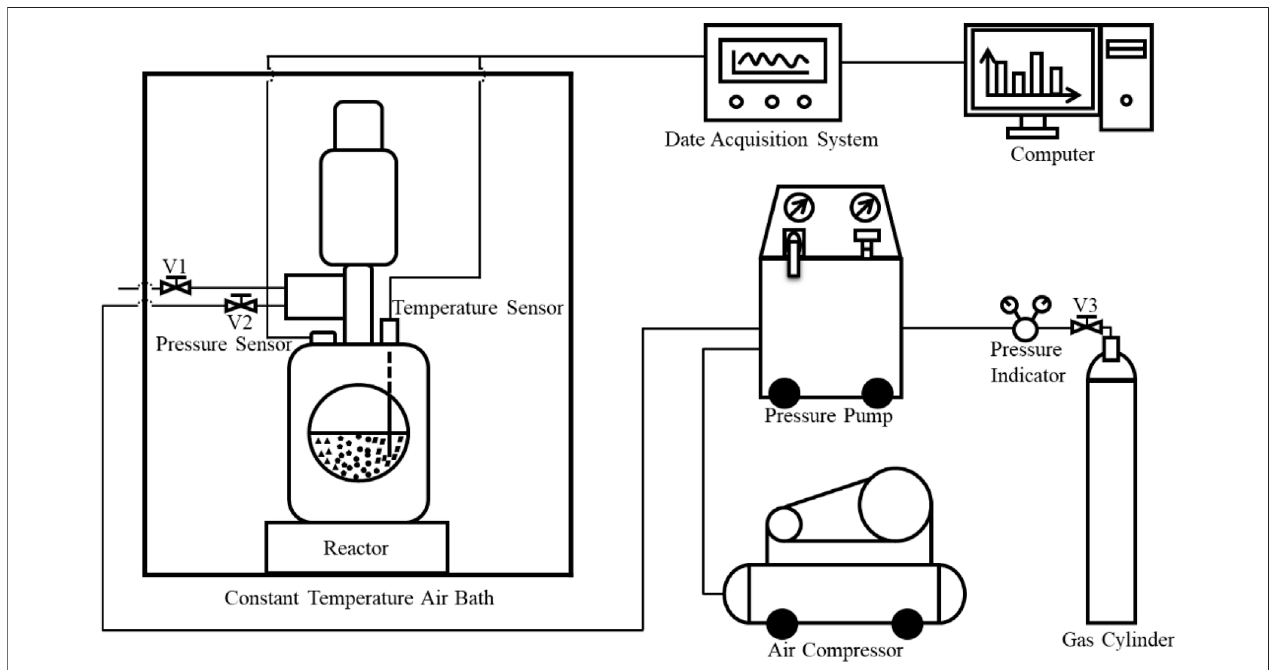
FIGURE 2 | Experimental apparatus for CO 2 hydrate growth kinetics in coal particles.